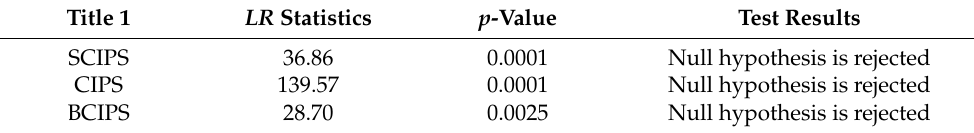
Table 5. Hypothesis Test Results of the Tobit Model of Different Beef Calf Production